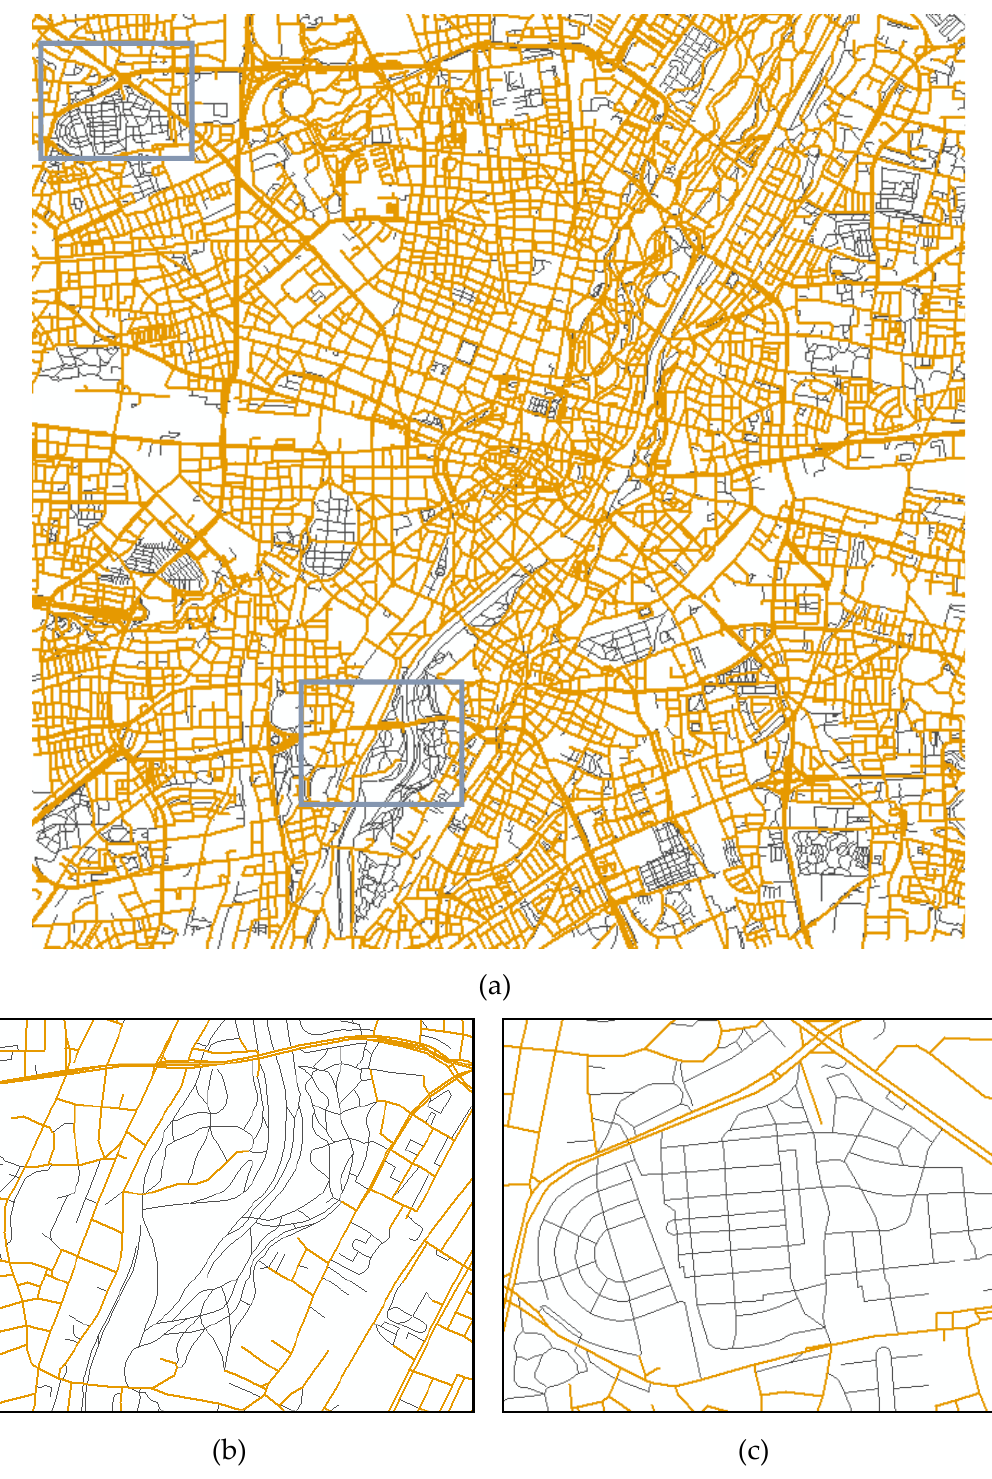
Figure 8. An example of the conflated road network in a built-up area: ( a ) a randomly selected area of 10 × 10 km 2 in Munich, Germany; ( b ) partial enlarged view of (a); ( c ) partial enlarged view of (a). Orange: the initial road network of NAVTEQ; grey: the conflated roads from ATKIS.